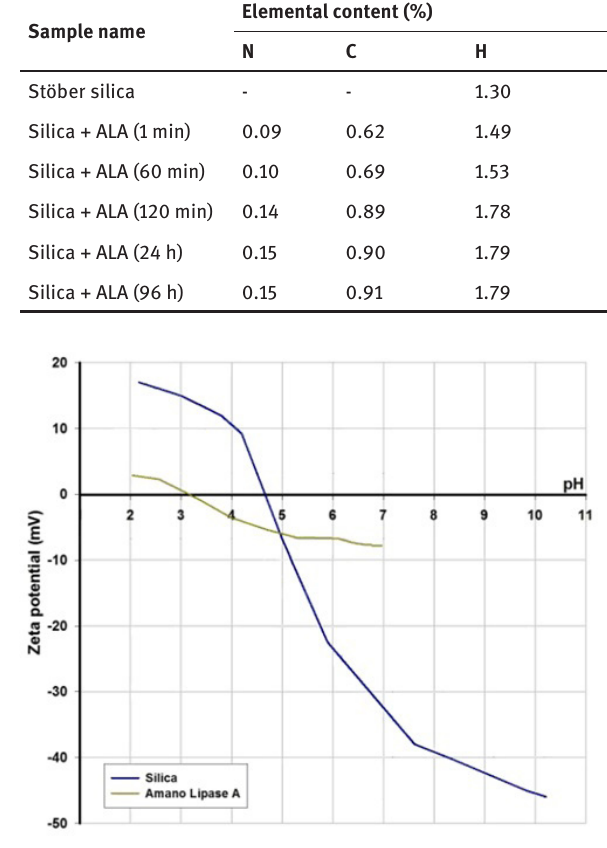
Figure 5: Zeta potential of Stöber silica and Amano Lipase A .